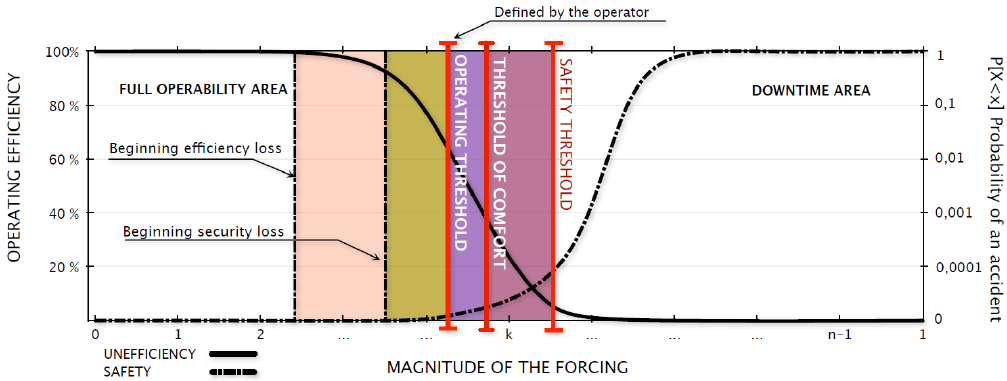
Figure 6. Theoretical relation between the magnitude of the forcing and the operation efficiency. Reproduced from Molina (2015) [27].